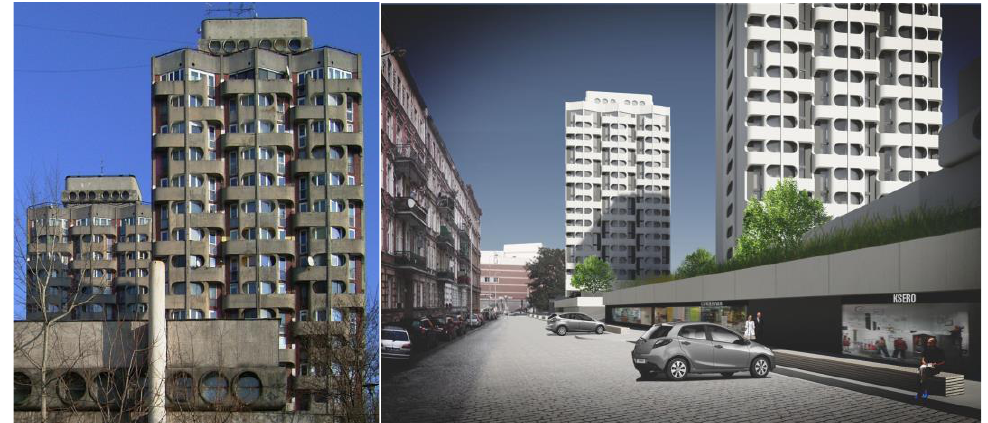
Figure 3. The renovation concept of the façades of residential buildings at Grunwaldzki square—a pre-refurbishment condition in 2007 and remodelling visualisation (photograph by the Authors). Table 2. The thermal modernisation building solutions for the residential buildings at Grunwaldzki square [elaborated by the Authors based on 19].